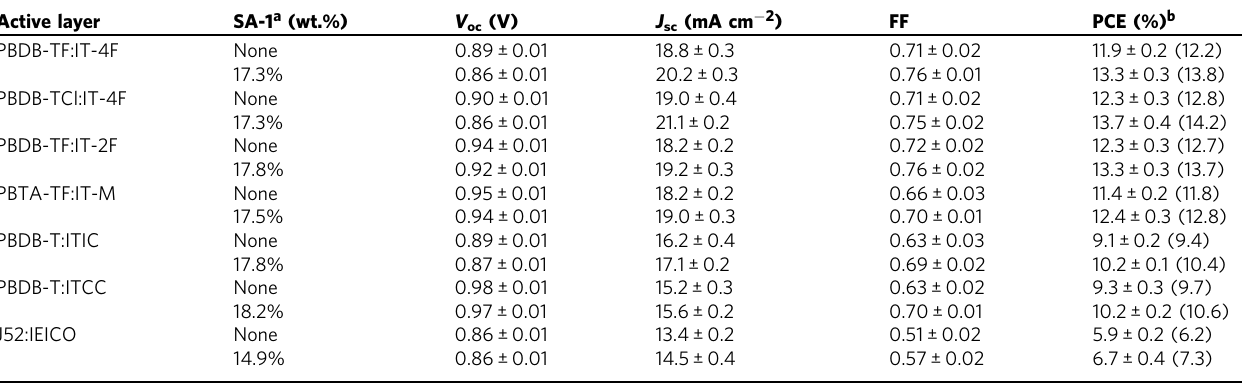
a The weight ratios of SA-1 for different systems are calculated from each case when the mole ratio of NF acceptor and SA-1 is 1:1 b The maximum PCEs are shown in the